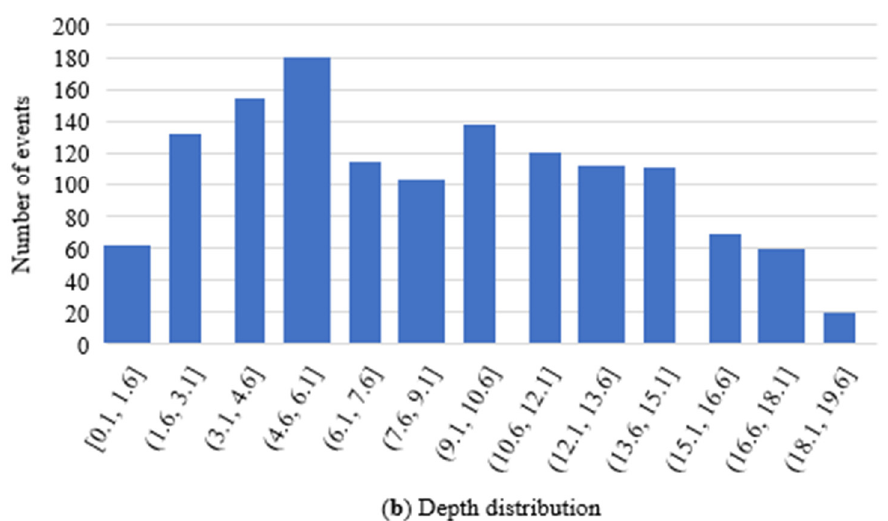
Figure 4. The histogram in ( a ) shows the magnitude distribution and the histogram in ( b ) shows the depth distribution of the events from the Southern California dataset used in experiments by the proposed model .